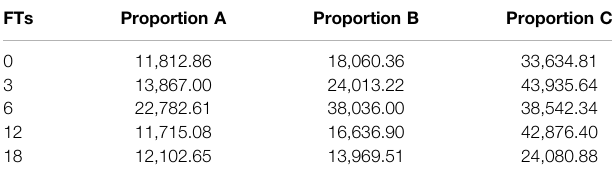
TABLE 3 | Deformation modulus of S/S sediments in FTs